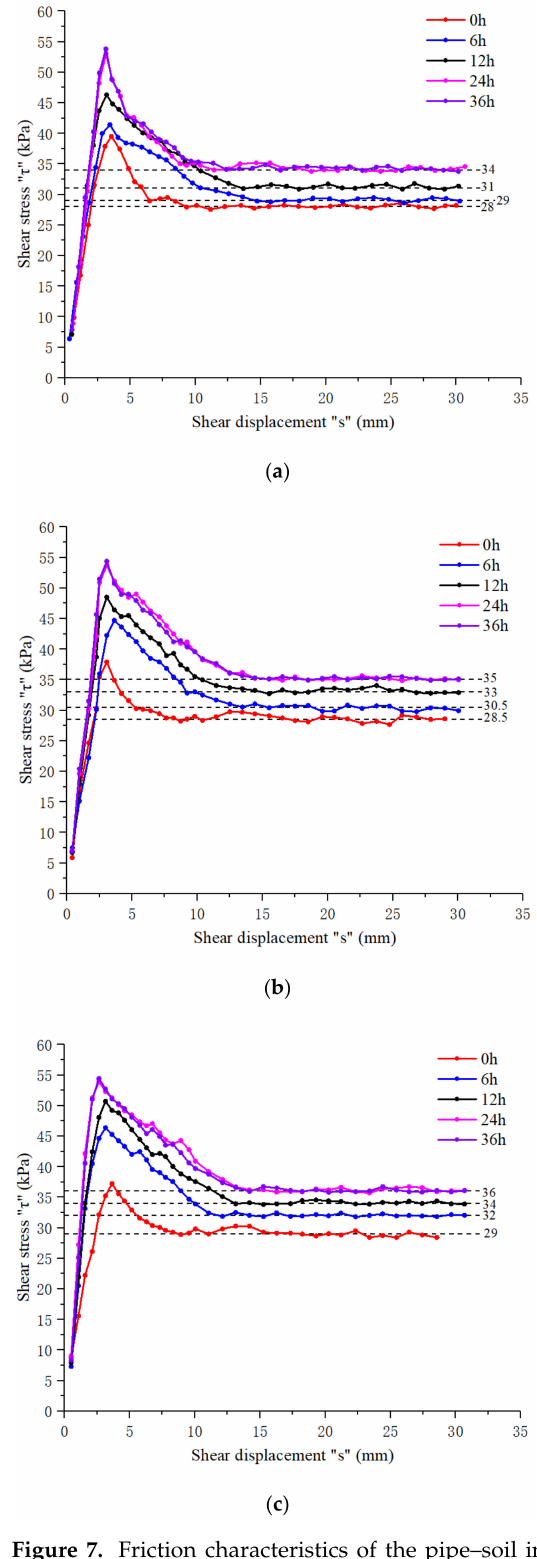
Figure 7. Friction characteristics of the pipe–soil interface with different slurry standing times. ( a ) “ τ –s” curve of the pipe–soil interface with slurry with a concentration range of 14%. ( b ) “ τ –s” curve of the pipe–soil interface with slurry with a concentration range of 16%. ( c ) “ τ –s ” curve of the pipe–soil interface with slurry with a concentration range of